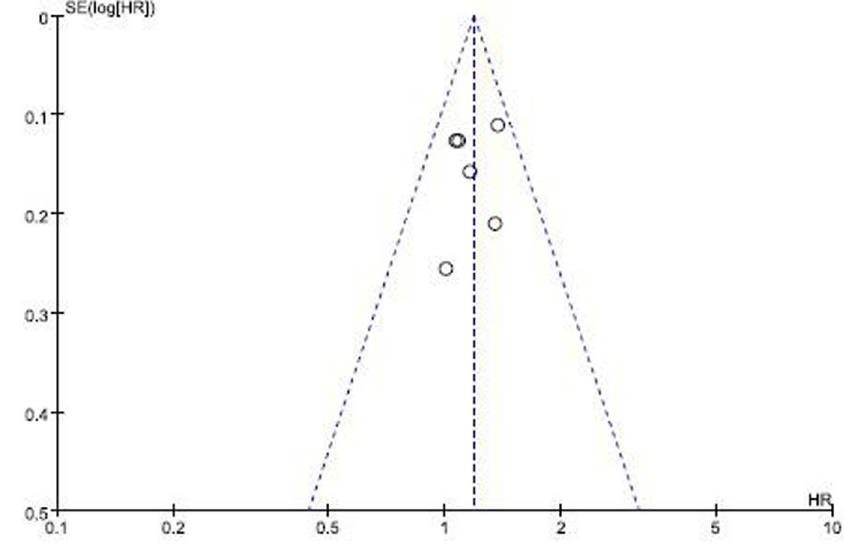
Figure 5. Results of the funnel plot of studies evaluating the effect of PCI on overall survival: HR, Hazard ratio.